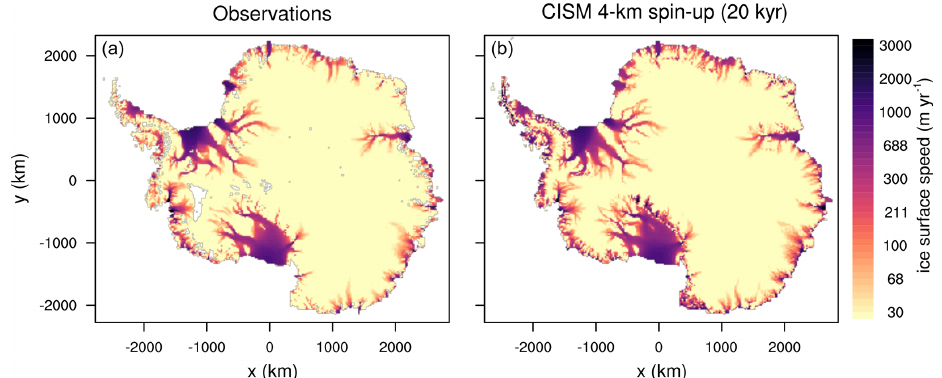
Figure 4. Antarctic ice surface speed (myr − 1 , log scale) from (a) observations (Rignot et al., 2011) and (b) the end of a 20kyr CISM spin-up at 4km resolution using the nonlocal-MeanAnt melt parameterization and calibration.